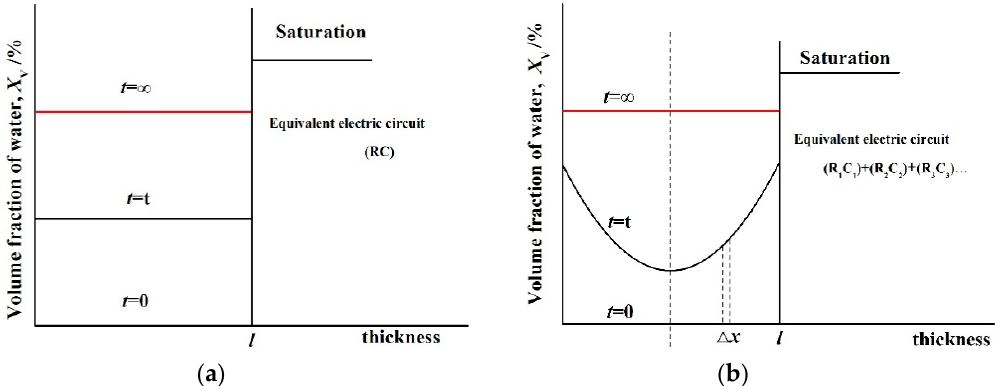
Figure 8. Schematic of water concentration profile in a free polymer of uniform thickness with an equivalent electric circuit according to ( a ) direct and ( b ) continuous models.